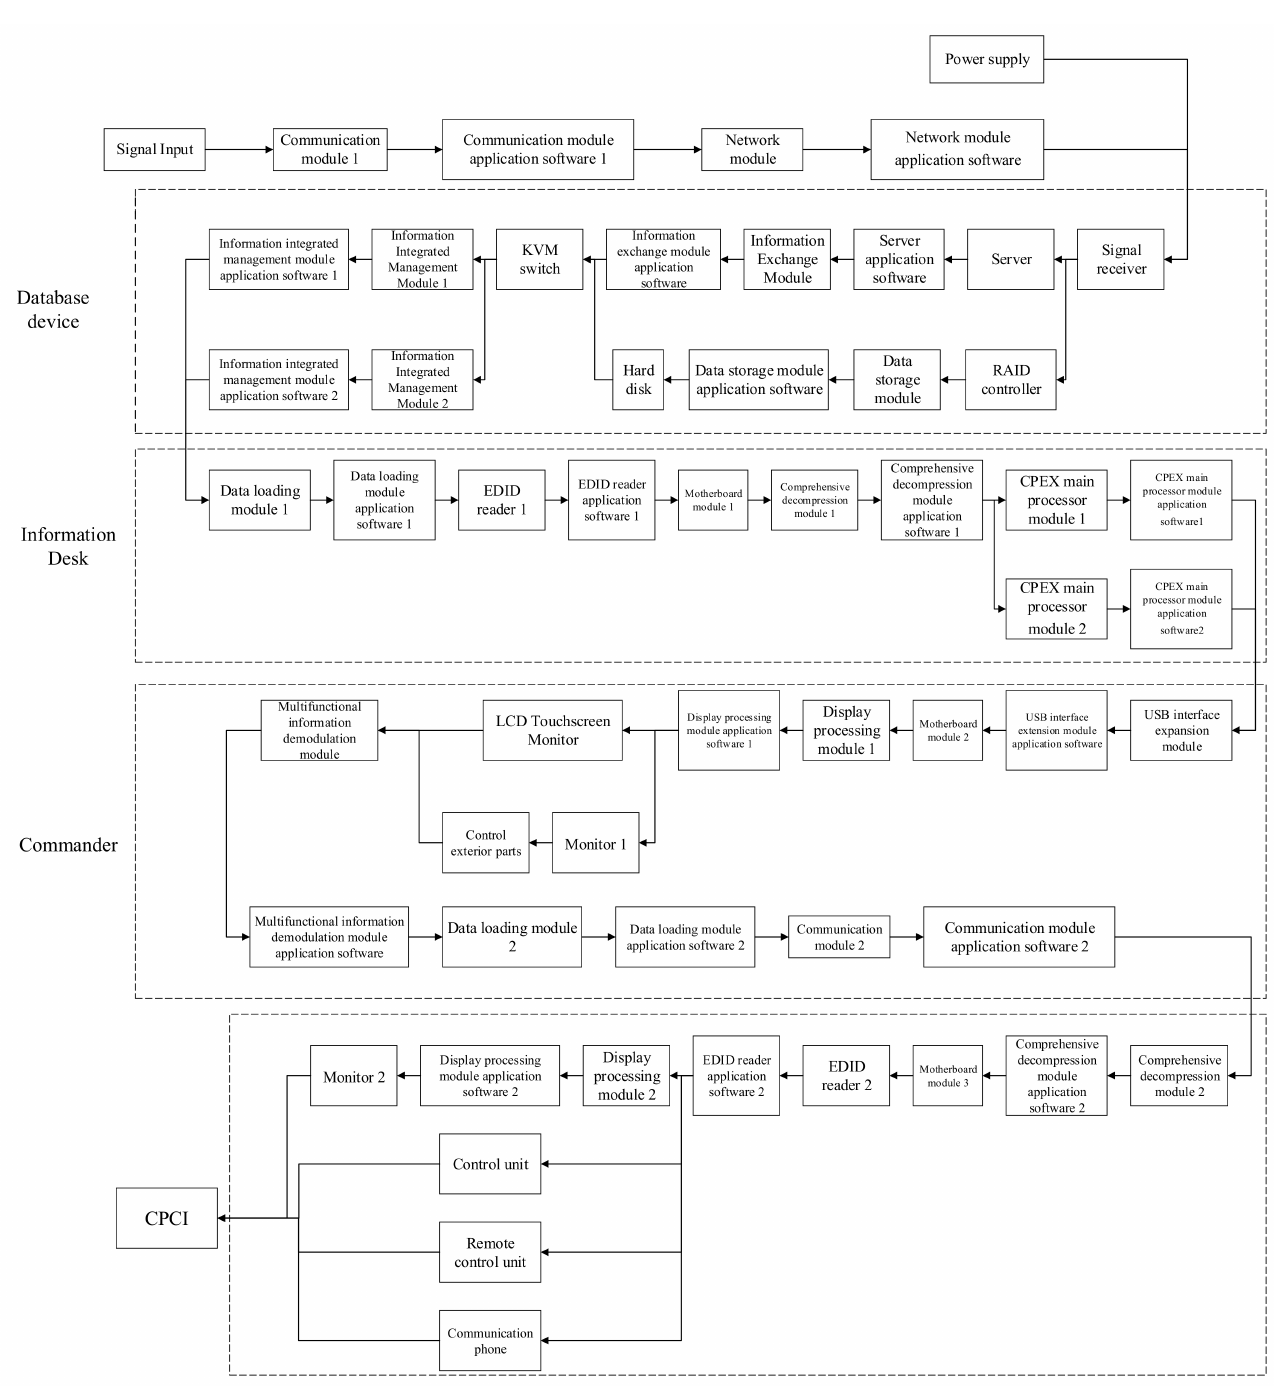
Figure 2. The schematic diagram of the C 4 ISR